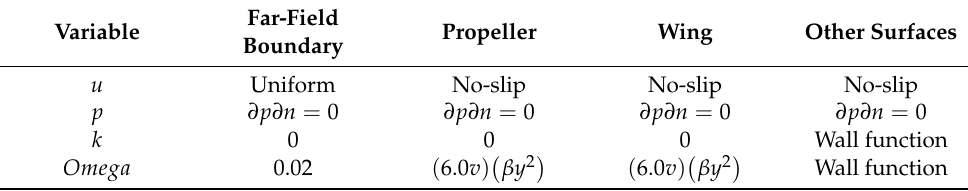
Table 5. Boundary